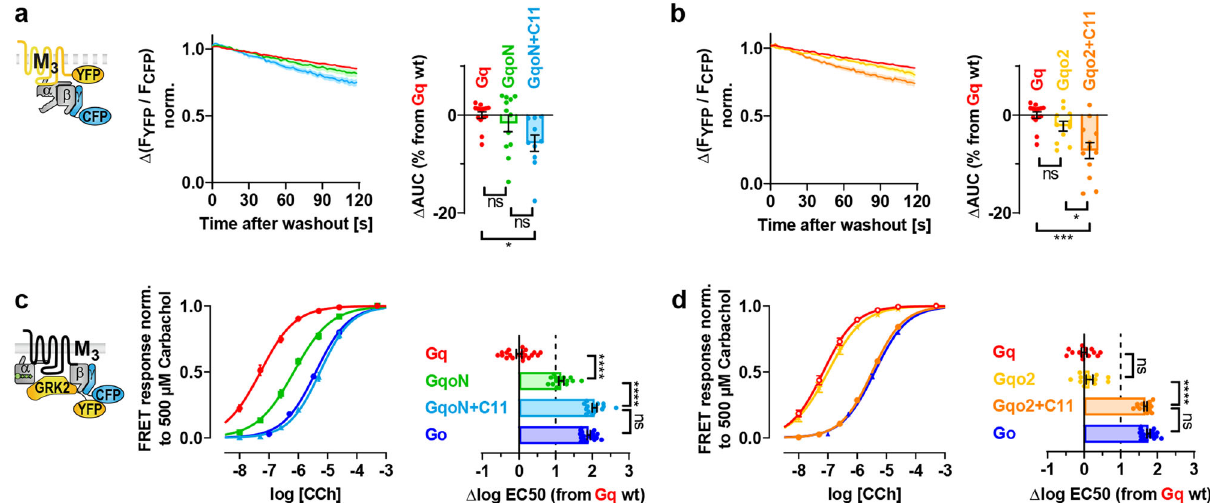
Fig. 4 Chimeric Gq subunits retain their stability in M3 receptor complexes while activation is impaired. a – b G protein binding experiments of chimeric Gqo proteins containing conversely exchanged structures as illustrated in Fig. 3a, b were conducted similarly to Fig. 1b. Dissociation kinetics of M 3 R-G protein complexes were quanti fi ed by determining the AUC as described in Fig. 1b and plotted in the bar graphs as relative changes of the AUC from Gq. ( a Gq; n = 14, GqoN; n = 12 and GqoN + C11; n = 10. b Gqo 2 ; n = 11, Gqo 2 + C11; n = 12 and Gq; n = 14 duplicated from a ). c – d Indirect G protein activation measurements of Gqo constructs were performed in analogy to Fig. 2a, b. Individually calculated EC50 values were plotted in horizontal bars as relative changes from the averaged EC50 of Gq. ( c Gq; n = 20, GqoN; n = 14 GqoN + C11; n = 15, and Go; n = 19 duplicated from Fig. 3e. d Gqo 2 ; n = 12, Gqo 2 + C11; n = 15, Gq; n = 14 and Go; n = 19 duplicated from Fig. 3e). All data points are represented as means± SEM (error bars in the concentration-response curves are not visible if they were smaller than the size of the symbol) and colored as indicated in the corresponding bar graphs (Gq = red, GqoN = green, GqoN + C11 = light blue, Gqo2 = yellow, Gqo2 + C11 = orange, Go = blue). Statistical analyses were performed using one-way ANOVAs followed by Tukey ’ s posttests ( a – d , * P < 0.1, *** P < 0.001, **** P < 0.0001, ns if P ≥